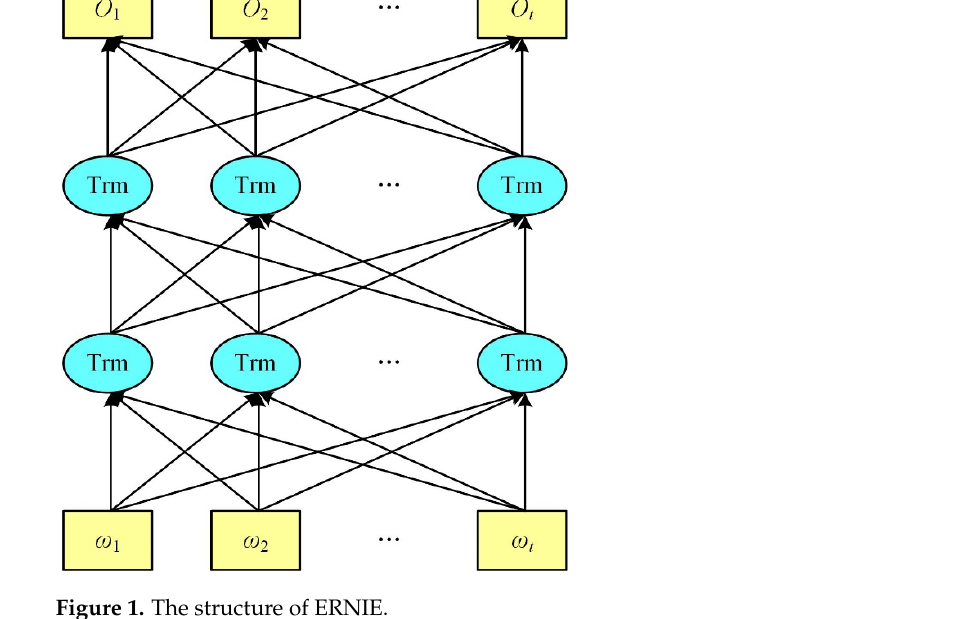
Figure 1. The structure of ERNIE.